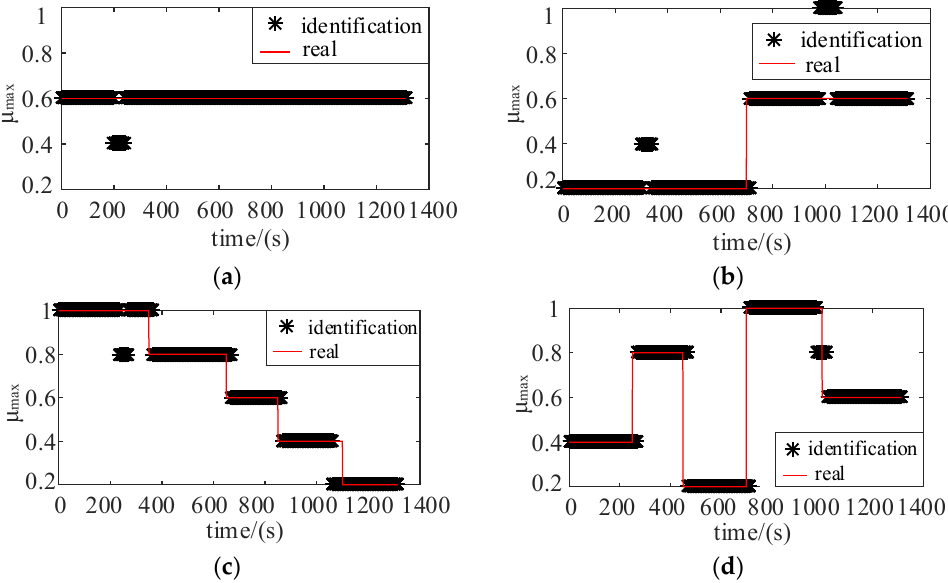
Figure 15. ( a ) Single pavement; ( b ) Combination of double pavement; ( c ) Multi-road combination, stepped pavement; ( d ) Multi-road combination, fully mixed pavement (including 1.0/0.8/0.6/0.4/0.2).